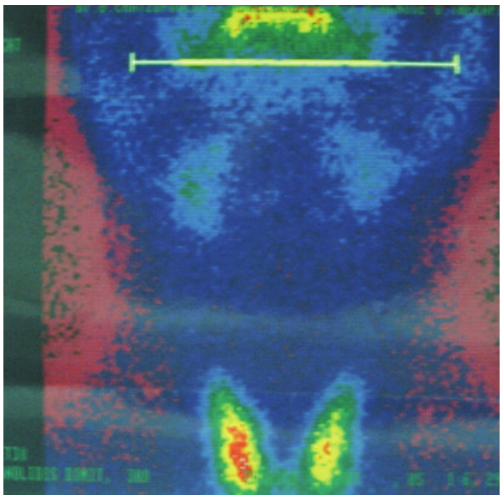
Figure 12: The macroscopic image of the surgical extract showing the cystic formation (5,4cm) of our second